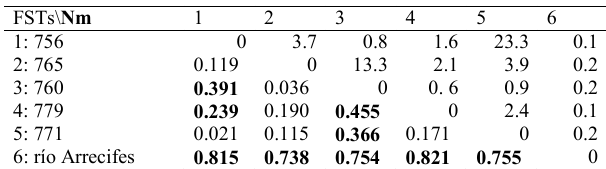
Table 6. Population pairwise estimates of F and the corresponding indirect estimations of gene flow values (above) found among different collecting sites in Pimelodus albicans . Numbers in bold indicate the significant Fst P values